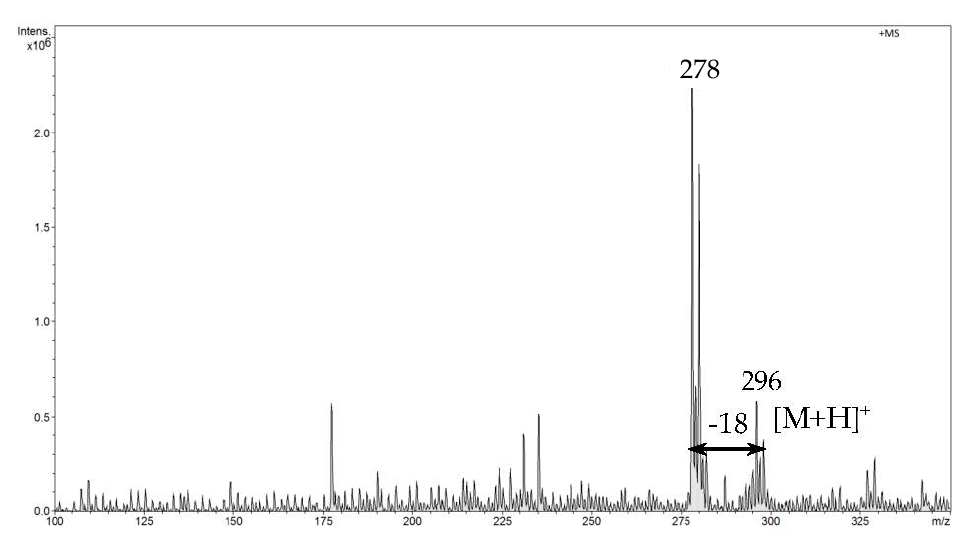
Figure 6. The FAPA ‐ MS spectrum of naproxen.